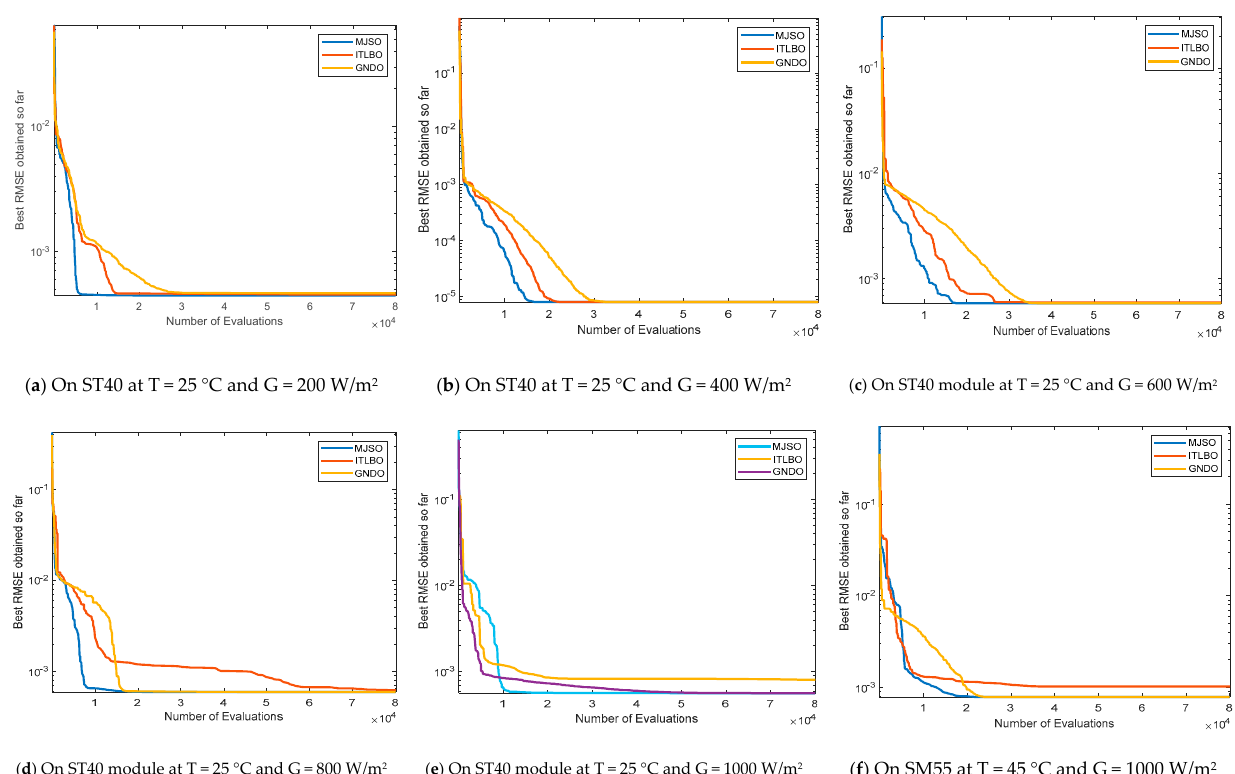
Figure 28. Depiction of error value between all I measured and estimated data on the ST40 module at different T and G = 1000.